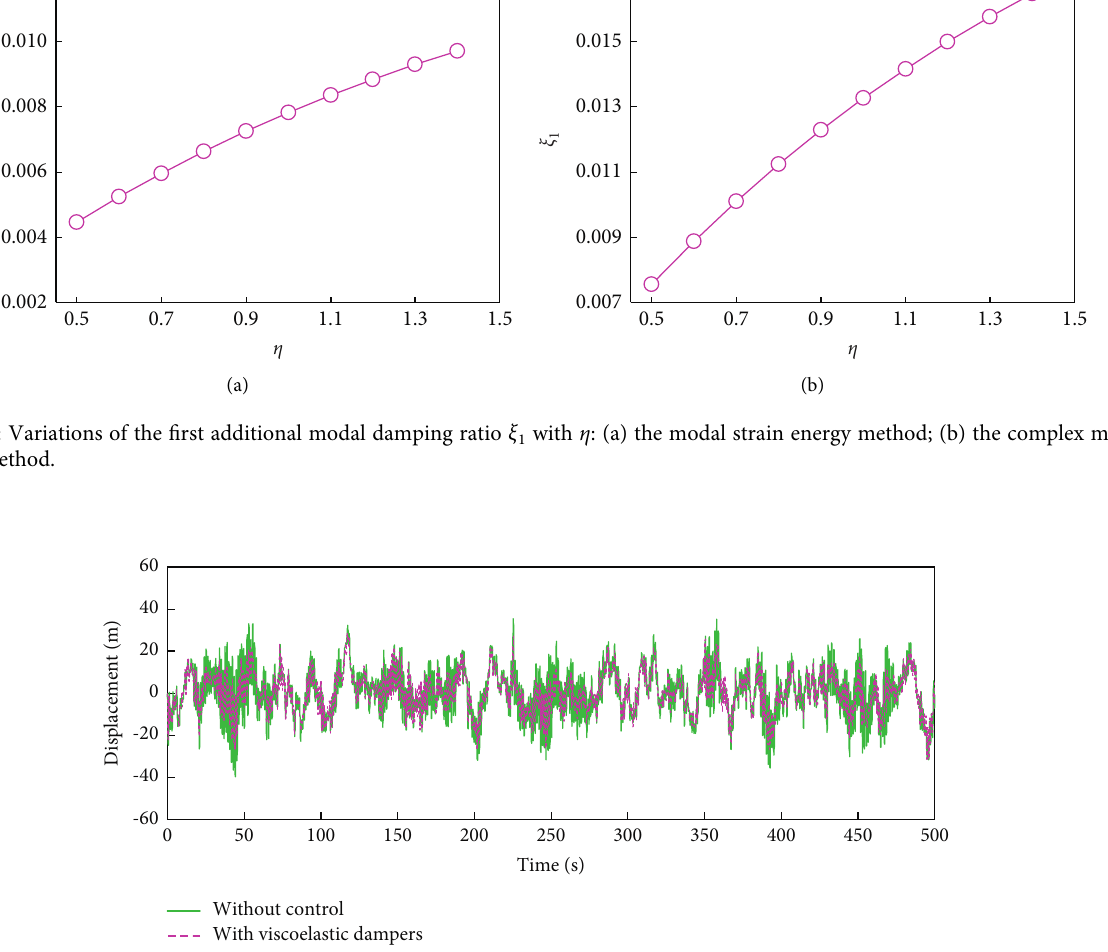
Figure 16: Time history response of the top displacement of the transmission line